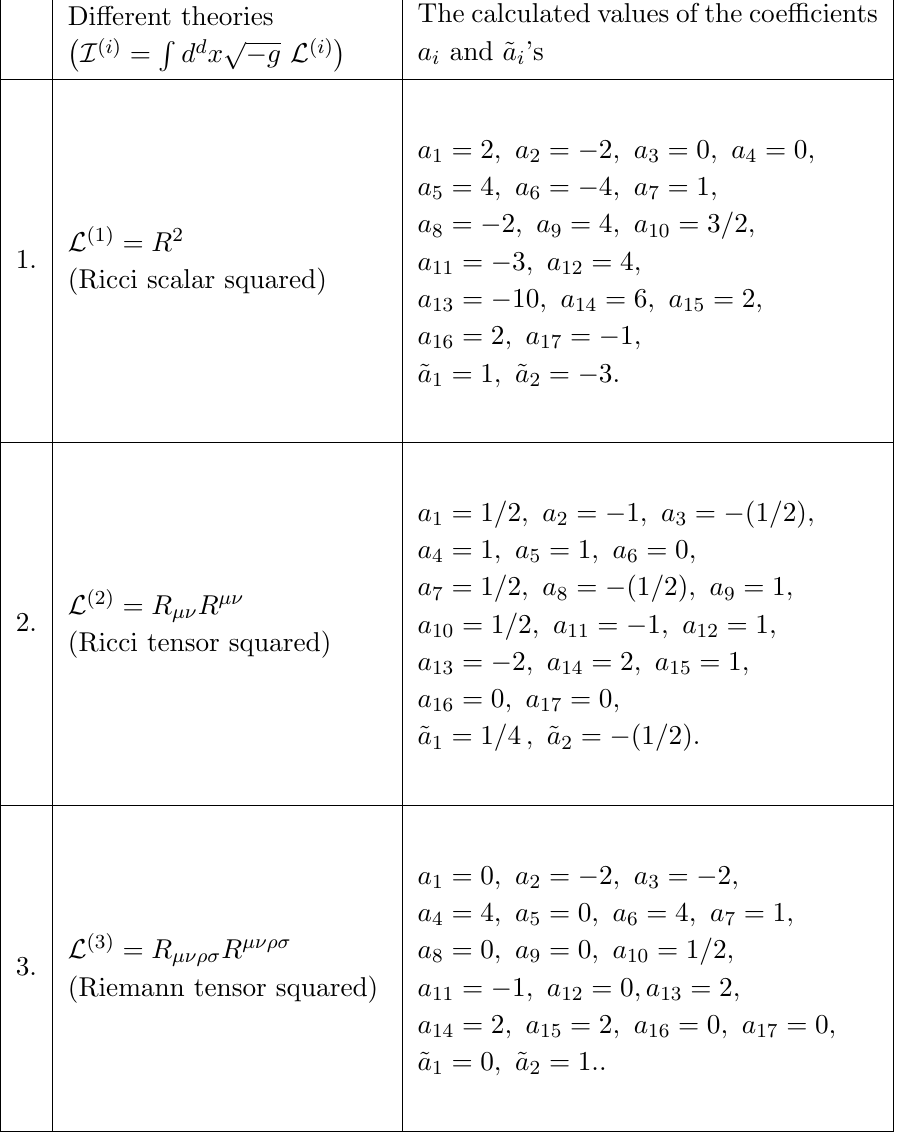
Table 8 . Explicit calculation for each of the three theories produces these values of the coe(cid:14)cients a i , appearing in E HD = (cid:0) P 17 a i T i (cid:0) P 2 ~ a i e T i , for 4-derivative theories of vv i =1 i =1